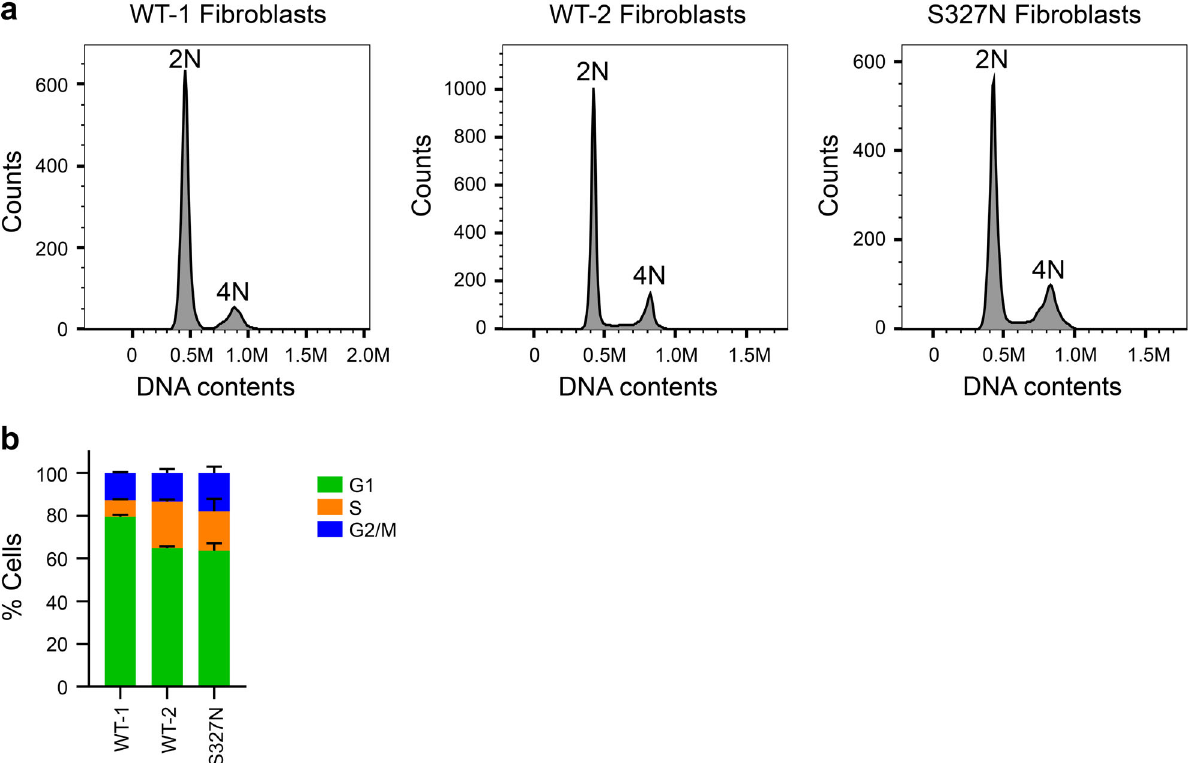
Fig. 3 Cell cycle pro fi les of STAG2 WT and Ser327Asn fi broblasts. a Two independent lines of WT fi broblasts (WT-1 and WT-2) and STAG2 Ser327Asn fi broblasts were cultured and stained with propidium iodide and anti-MPM2 antibody. Cells were harvested and analyzed by fl ow cytometry. Representative graphs are shown, with the cell populations with 2N and 4N DNA contents indicated. b Quanti fi cation of the fi broblasts in G1, S, and G2/M in a ( n = 2 independent